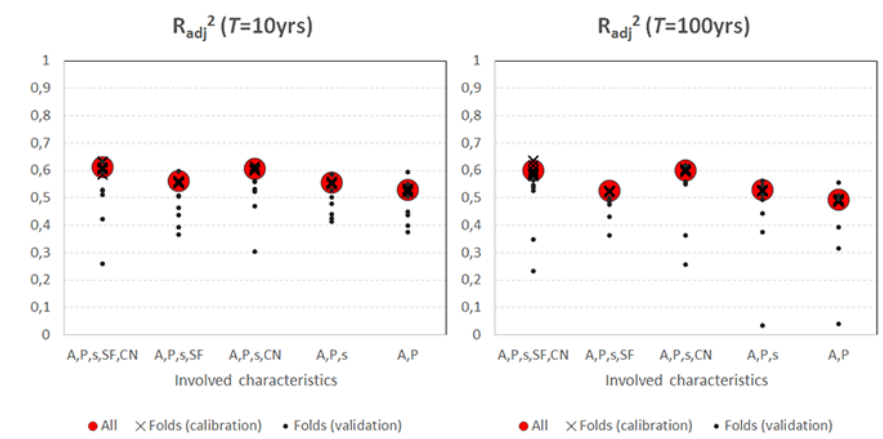
Figure 15. Values of the determination coefficient for calibration to the whole data set and for calibration and validation using 7 folds for T = 10 years (left panel) and T = 100 years (right panel).